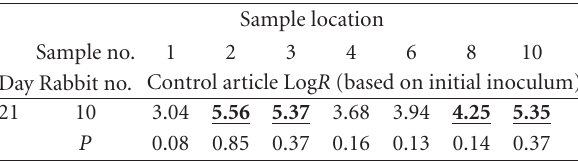
Table 4: Tissue (CFU/g) Log reduction summary tables for day 30. Log reduction values higher than 4 are bold and